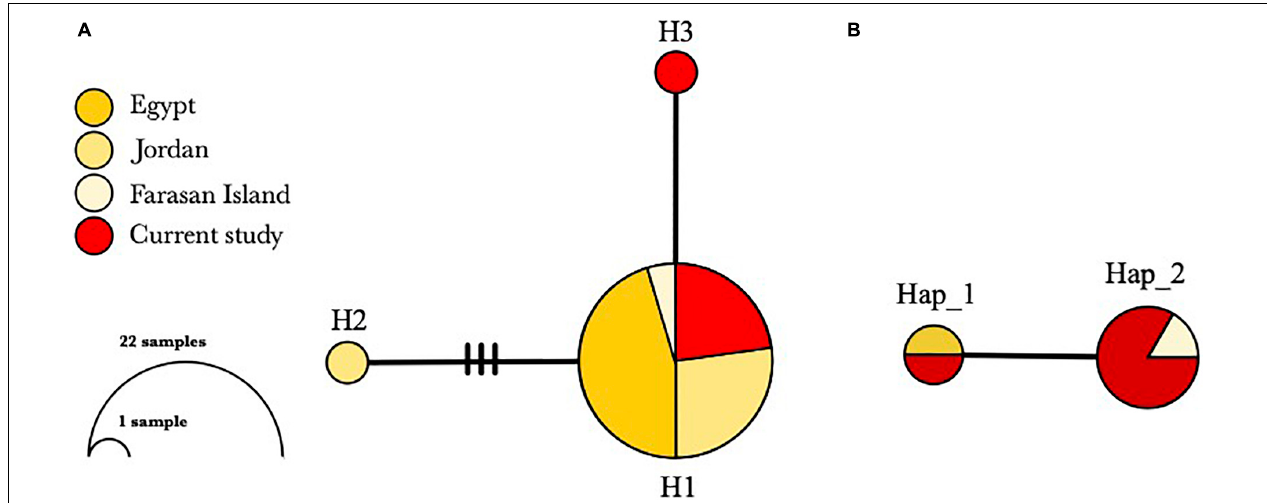
FIGURE 3 | Haplotype networks based on (A) 24 16S sequences and (B) eight mtCOI sequences of T. squamosina in the Red Sea. Each circle corresponds to one haplotype (H for 16S; Hap for mtCOI) and the size of each circle is proportional to its frequency. Connecting lines between haplotypes represent one mutational step with additional mutational steps represented by the hatches.